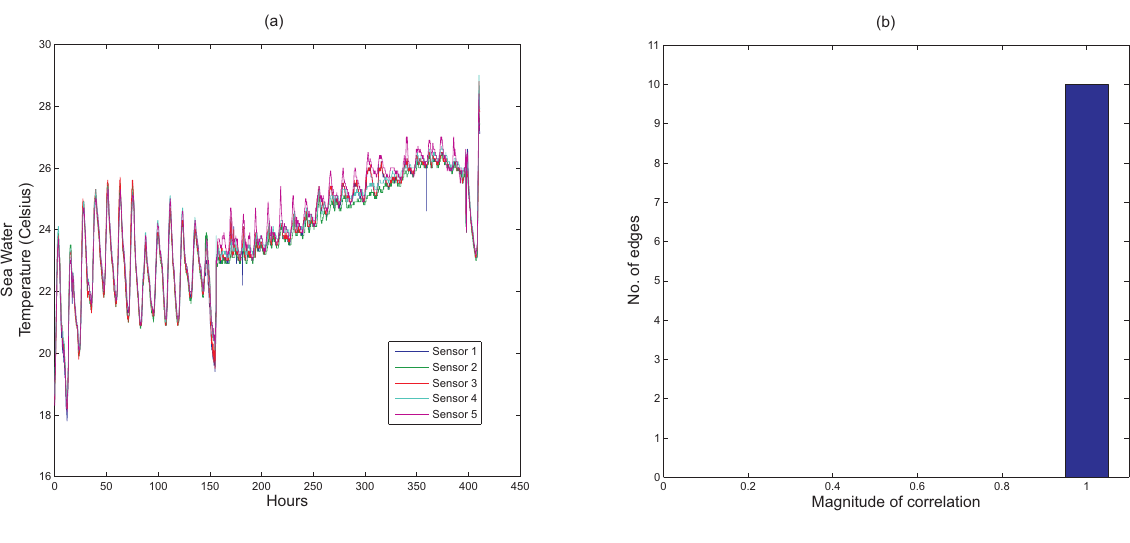
Figure 6. (a) Temperature readings from sensors deployed in Nelly Bay, Great Barrier Reef, Australia over a period of 17 days; (b) Number of edges with correlation close to